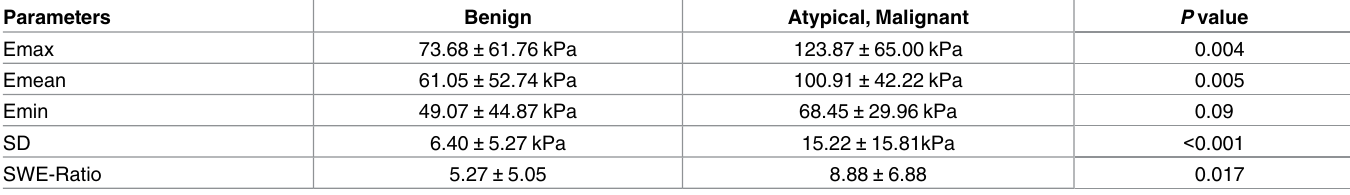
Table 3. Quantitative shear-wave elastography parameters.